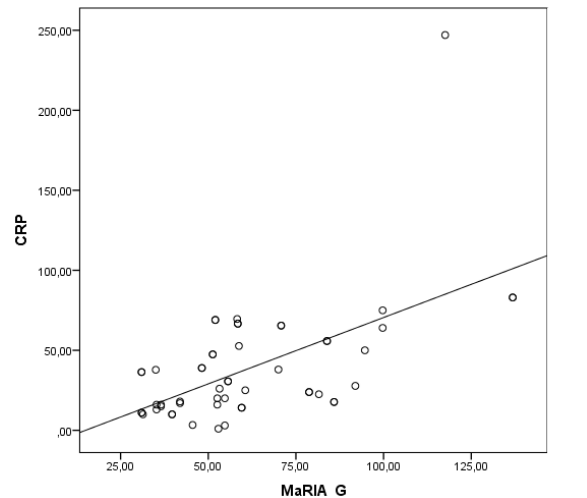
Figure 5: The sensitivity and specificity of Magnetic Resonance Index of Activity Global and the Lemann Index in detecting active Crohn’s Disease at endoscopy (Crohn’s Disease Endoscopic Index of Severity ≥ 9, P<0.01).